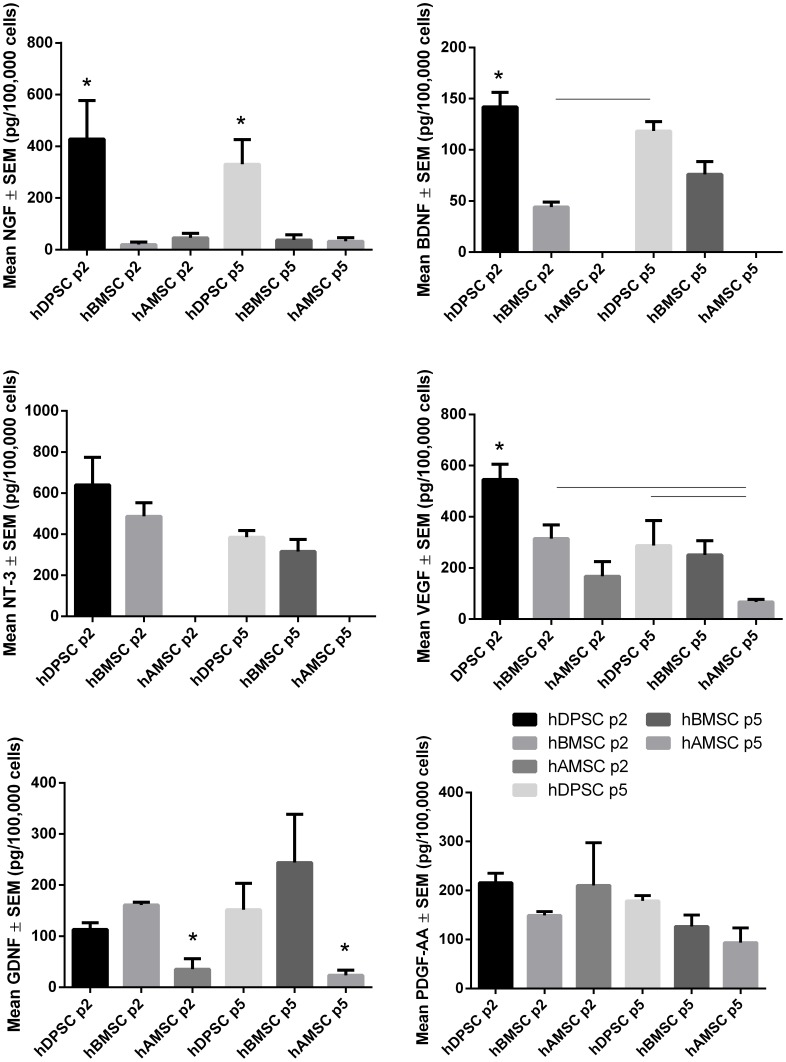
NGF, BDNF, NT-3, CNTF, VEGF, GDNF, PDGF-AA and PDGF-AB/BB titres by ELISA in hDPSC, hBMSC and hAMSC. hDPSC-, hBMSC- and hAMSC-conditioned media (passage 2 and 5) collected after 48 h of cell culture.(n = 3; asterisks indicate significant differences from all other samples/black lines indicate significant difference between specific samples at p<0.05). CNTF and PDGF-AB/BB were undetectable in all samples.